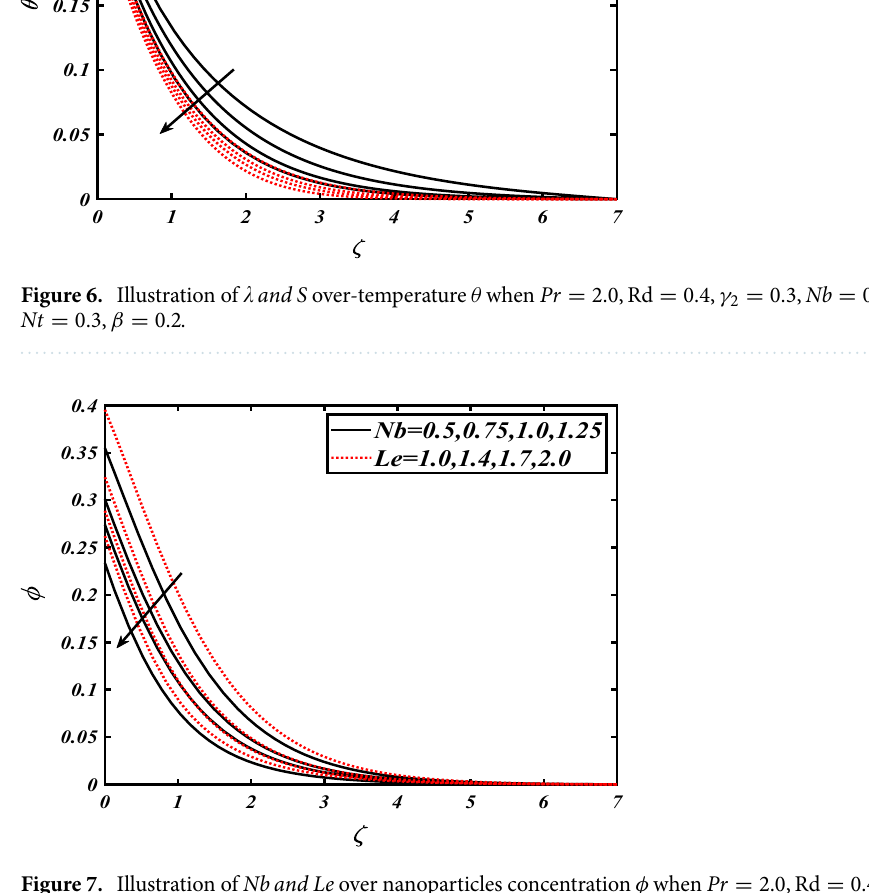
Figure 7. Illustration of Nb and Le over nanoparticles concentration φ when Pr = 2.0, Rd = 0.4, γ 2 = 0.3, γ 1 = 0.3, Nt = 0.3, S = 0.5, (cid:31) = 0.5, β = 0.2 .